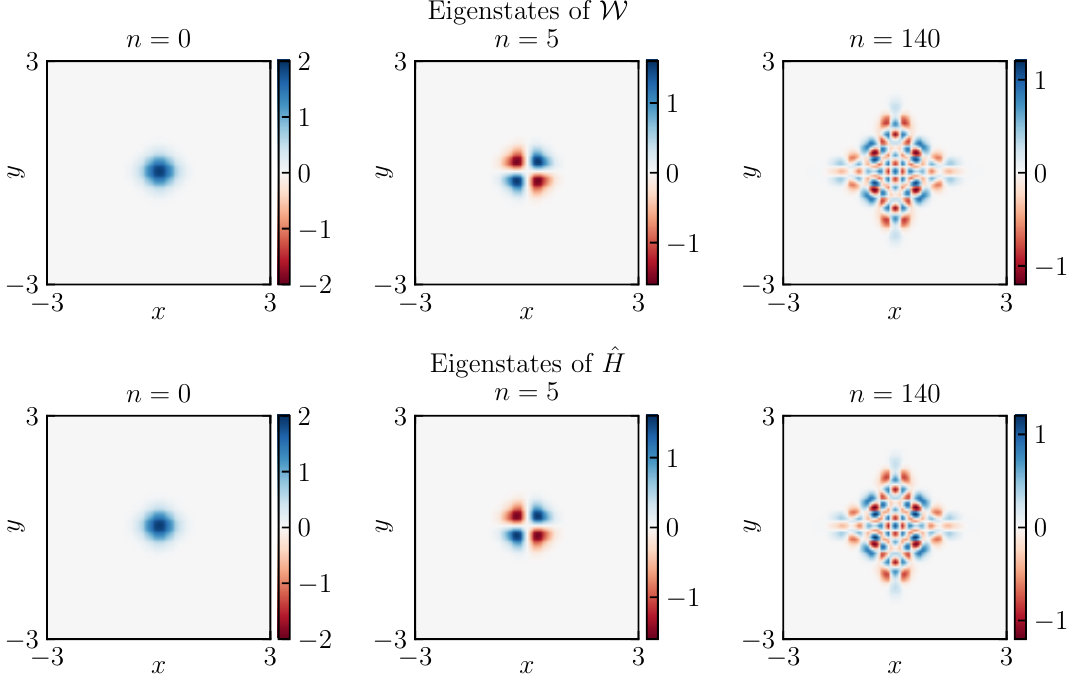
Figure 8: Comparison of the classical eigenstates obtained from the Gibbs dis- tribution and quantum eigenstates obtained solving the stationary Schrödinger equation for a two-dimensional potential. Inverse temperature β = 1, potential corresponding to Eq. (80) with m = ω = 1, δ = 0.1, ν = 20 and ε = ħ h =